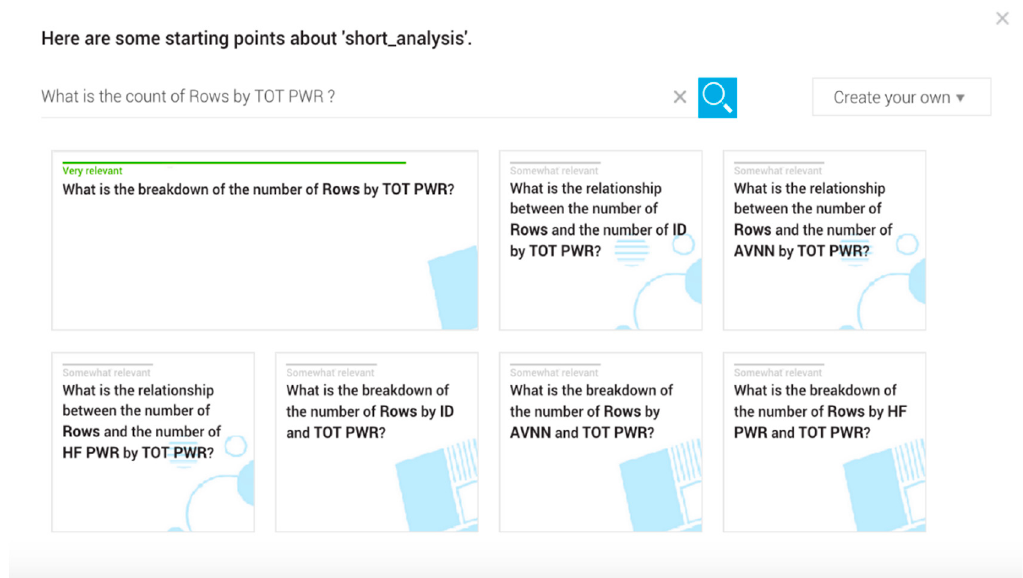
Figure 7. Proposals for links automatically detected in “Explore” mode.